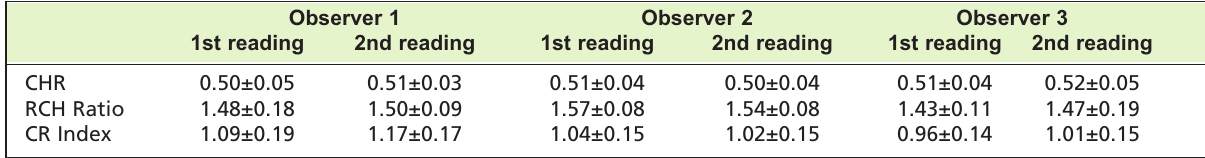
Mean values of measurements by all the observers with standard deviations Table I: